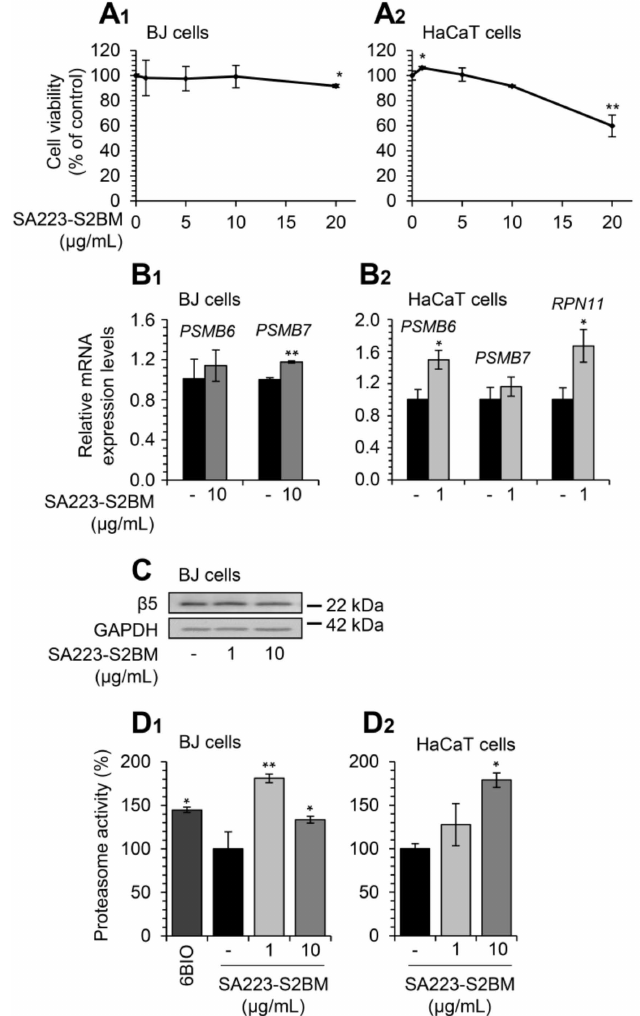
Figure 2. The extract SA223-S2BM exerts no toxicity in human normal skin fibroblasts and im- mortalized keratinocytes and activates UPP. ( A 1 , A 2 ) Relative (%) survival levels (MTT assay) of BJ skin fibroblasts ( A 1 ) and HaCaT keratinocytes ( A 2 ) exposed to the indicated concentrations of the SA223-S2BM extract for 24 h. ( B 1 ) Relative expression levels of 20S ( PSMB6, PSMB7) proteasome genes in BJ cells after incubation with 10 µ g/mL of the SA223-S2BM extract for 24 h. ( B 2 ) Relative expression levels of 20S ( PSMB6, PSMB7 ) and 19S ( RPN11 ) proteasome genes in HaCaT cells after treatment with 1 µ g/mL of the extract for 24 h. ( C ) Representative immunoblotting analysis of the 26S proteasome subunit β 5 expression levels after a 24 h exposure of BJ cells to the shown concentrations of the extract. ( D 1 , D 2 ) Relative (%) chymotrypsin-like proteasome peptidase activity in BJ ( D 1 ) and HaCaT ( D 2 ) cells treated with the indicated concentrations of the SA223-S2BM extract for 24 h. The compound 6BIO (2 µ M) was used as a positive control. The HMBS gene expression ( B 1 , B 2 ) and GAPDH probing ( C ) were used as reference for RNA and protein input, respectively. Quantitation of shown blots is presented in Figure S2. In ( A 1 , A 2 , D 1 , D 2 ) control samples values were set to 100%; in ( B 1 , B 2 ) control samples values were set to 1; bars, ± SD ( n ≥ 2); * p < 0.05; ** p < 0.01. Additionally, Q-RT-PCR expression analyses revealed that treatment of BJ fibroblasts with the extract for 24 h induced the expression levels of ALP-related genes, named CTSB , CTSL , CTSD , and SQSTM1 , at a concentration of 10 µ g/mL (Figure 3A 1 ). Further, we observed that exposure of HaCaT cells to the extract for 24 h led to the induction of the expression levels of genes involved in ALP functionality ( CTSB , CTSL , CTSD , and SQSTM1 ) (Figure 3A 2